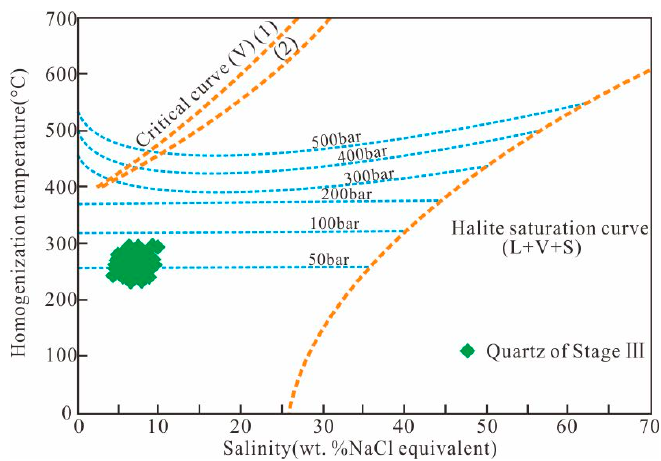
Figure 14. Trapping pressure estimation diagram. Summary plot of homogenization temperatures and salinities of FIs for the Chuduoqu Pb-Zn-Cu deposit. Vapor–liquid coexistence curves were calculated from the equations of Driesner and Heinrich [81].